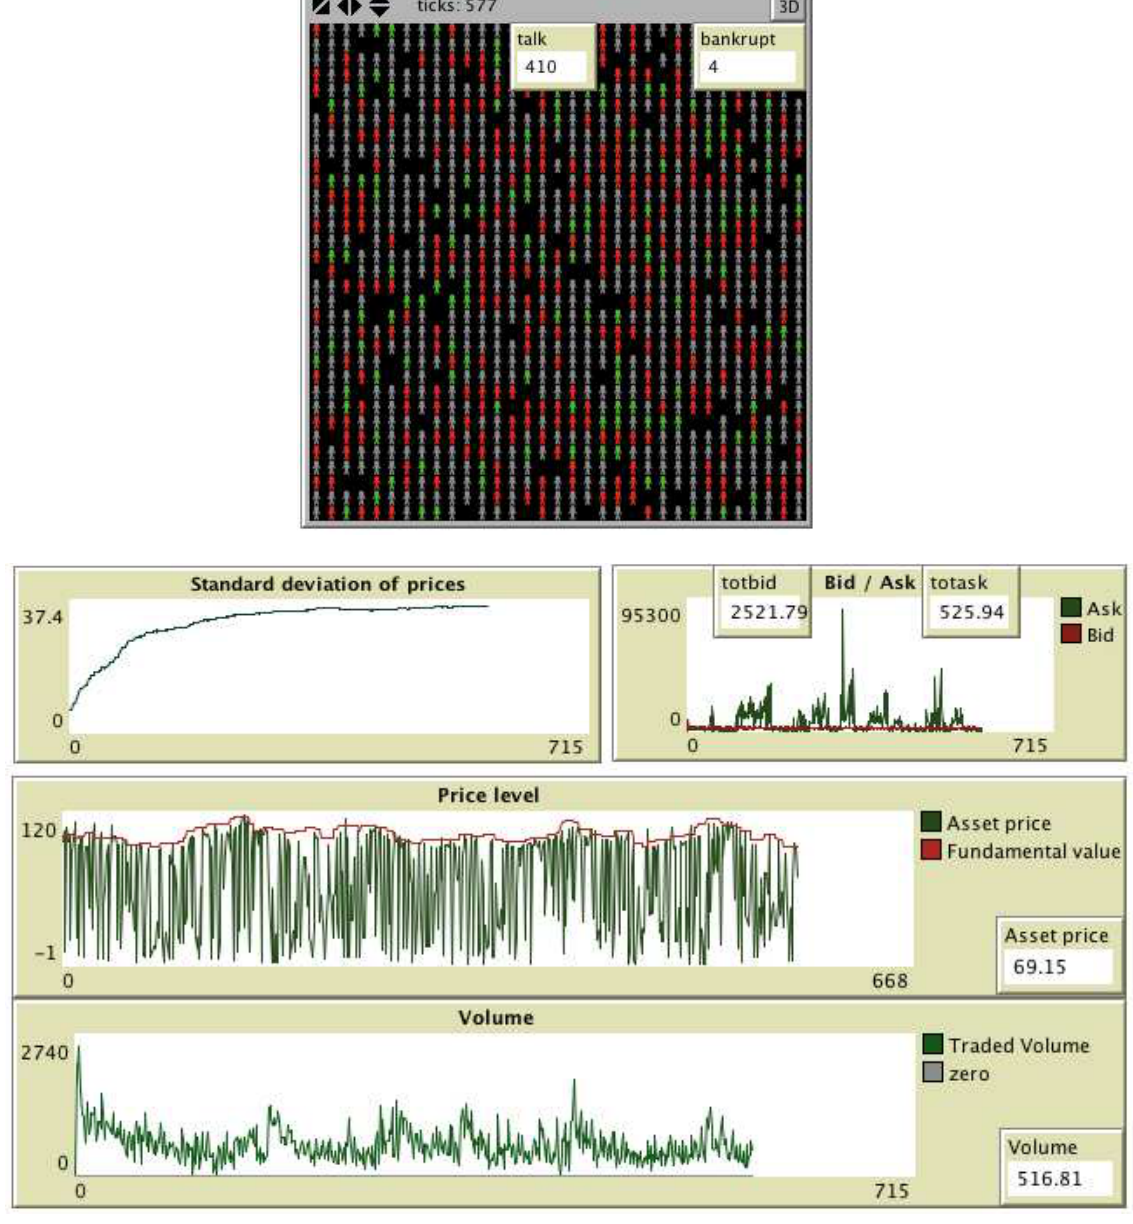
Figure 4. The evolution of stock market